Question: In one sentence, what is this figure communicating?
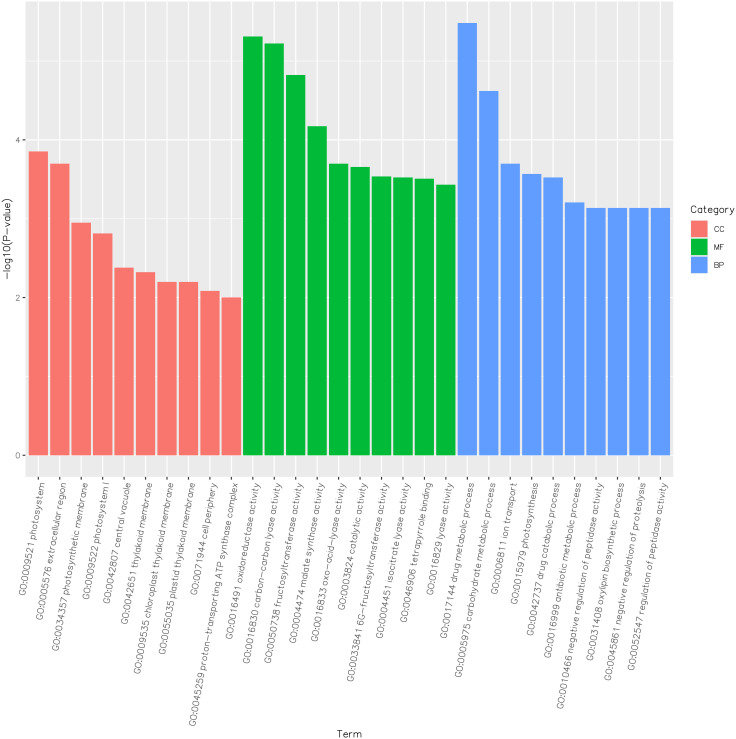
Answer: Column chart of GO enrichment analysis. According to molecular function (MF), biological process (BP), and cellular component (CC), GO classification was performed, and the top 10 GO term items with the lowest p-value and the most significant enrichment were selected to present.